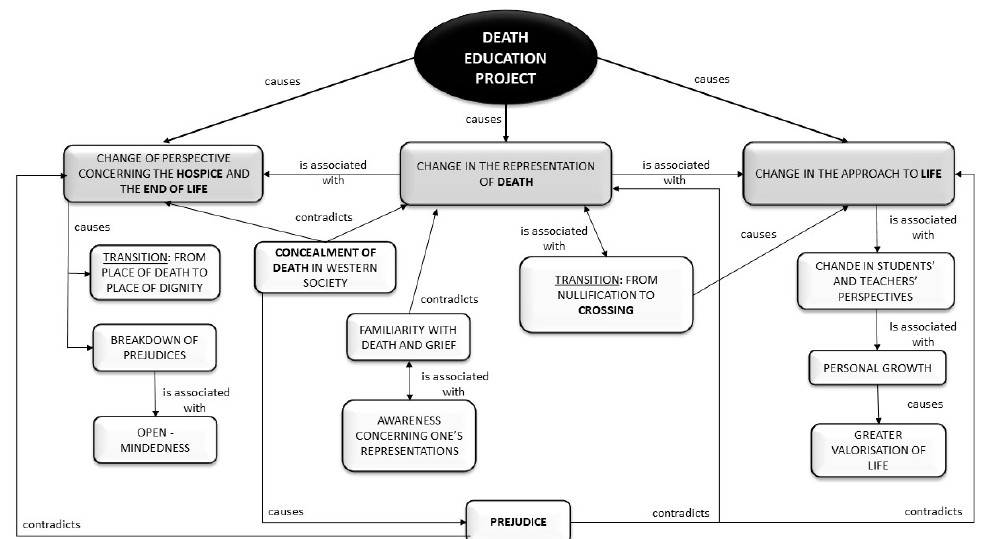
Figure 1. Changes following the death education initiative.